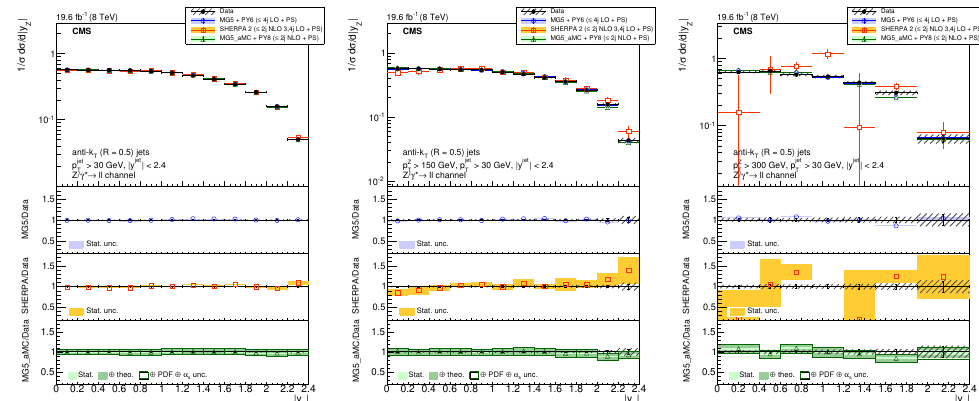
Figure 9 . The normalised di(cid:11)erential cross section for Z ( ! ‘‘ ) + jets production measured as a function of Z boson rapidity compared to the predictions calculated with MadGraph 5 + pythia 6, sherpa 2, and mg5 a mc + pythia 8. The cross section is measured (left) inclusively with respect to the Z boson p T , (middle) for p T > 150 GeV, and (right) for p T > 300 GeV. The lower panels show the ratios of the theoretical predictions to the measurements. Error bars around the experimental points show the statistical uncertainty, while the cross-hatched bands indicate the statistical and systematic uncertainties added in quadrature. The boxes around the mg5 a mc + pythia 8 to measurement ratio represent the uncertainty on the prediction, including statistical, theoretical (from scale variations), and PDF uncertainties. The dark green area represents the statistical and theoretical uncertainties only, while the light green area represents the statistical uncertainty alone.